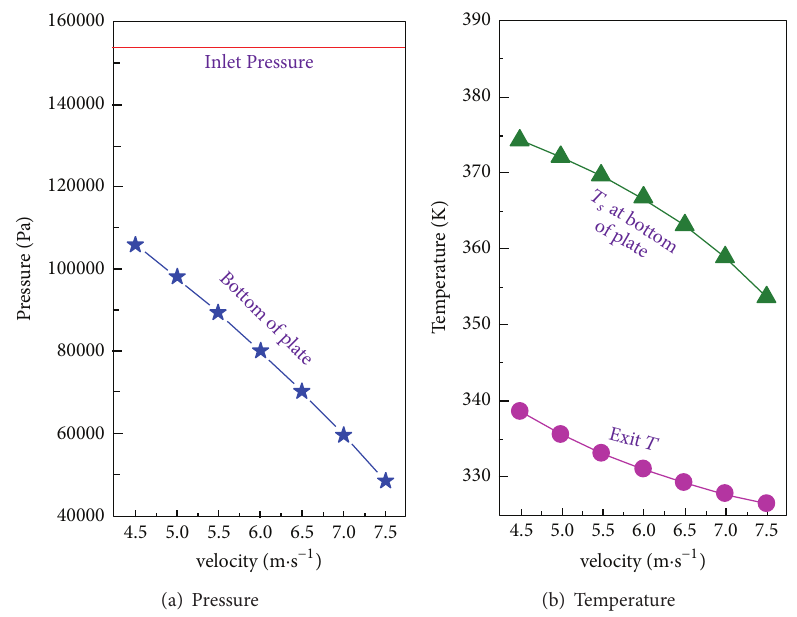
Figure 14: Pressure and temperature distributions at the bottom of fuel plates against inlet velocity.